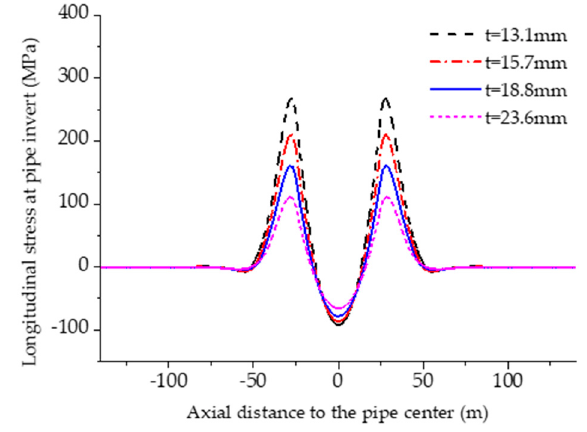
Figure 16. Longitudinal stresses at pipe invert for pipes with various wall thicknesses.